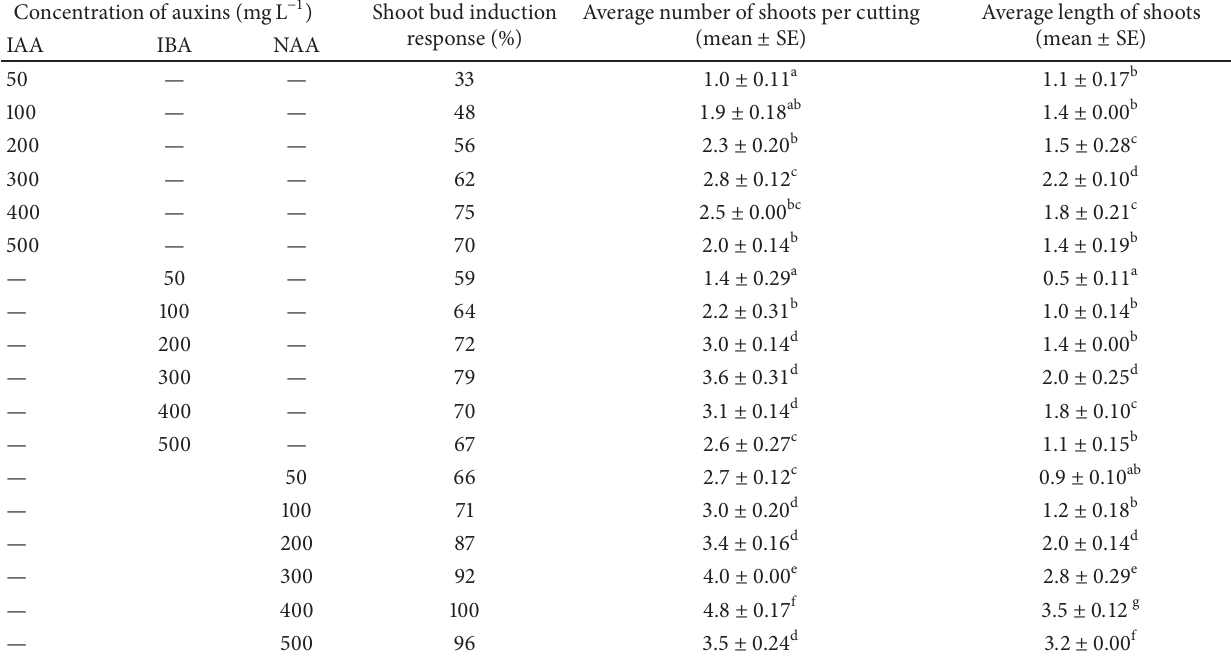
Table 1: The effect of auxins on shoot bud induction in stem cuttings of C. guianensis after 60 days of treatment under greenhouse condition. Concentration of auxins (mg L −1 )